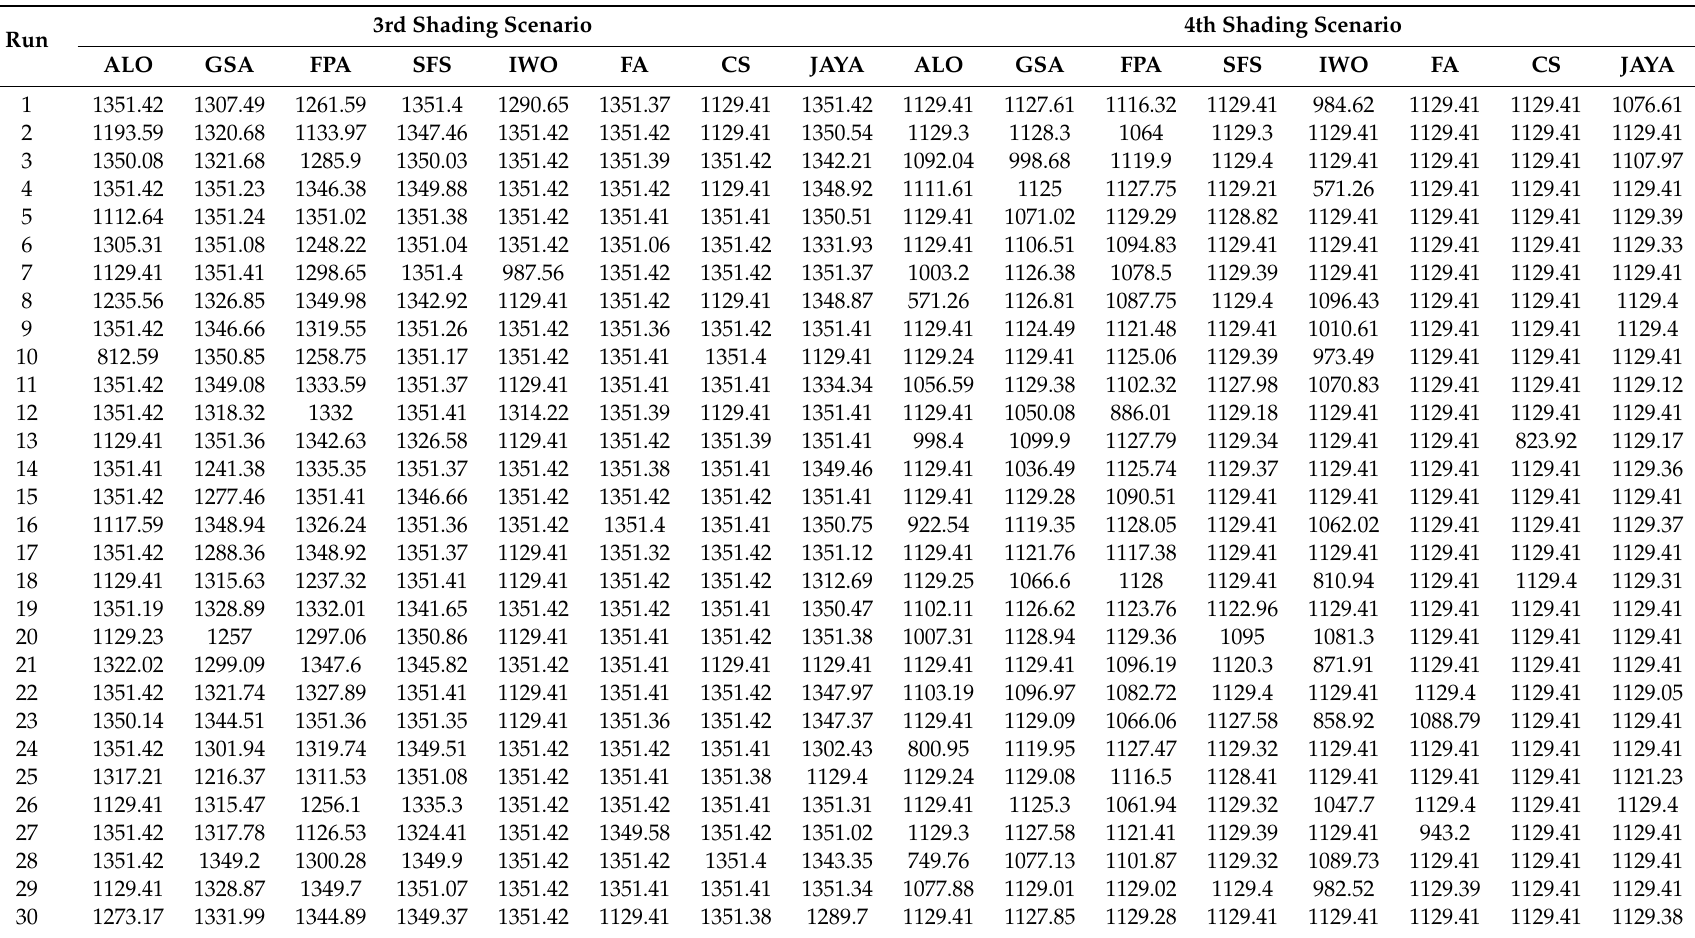
Table A2. The detailed performance of each optimizer for the 3rd and 4th shading